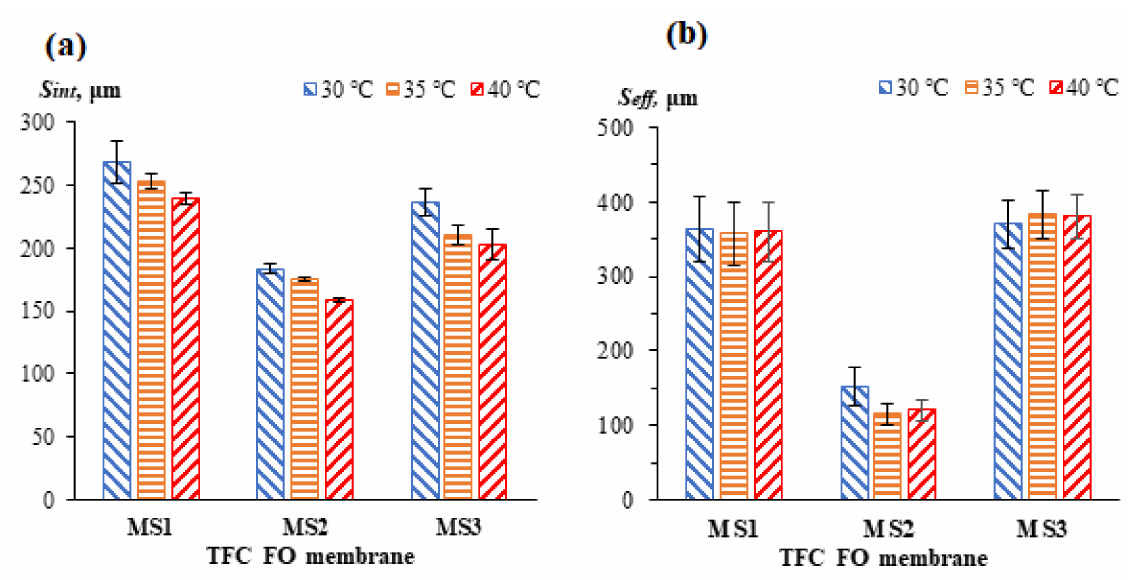
Figure 8. The ( a ) S int and ( b ) S eff values for the TFC FO membranes at different